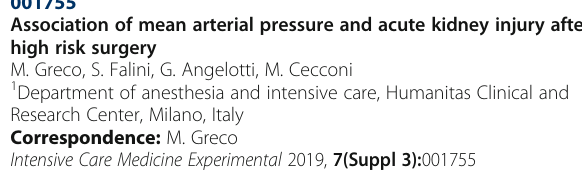
Fig. 1 (abstract 001755). See text for description